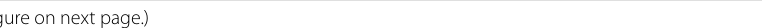
figure on next Fig. 5 Effects of miR‑29b gene transfer on renal injury in vivo. A Assessment of apoptosis. Representative epifluorescence images of TUNEL labeling of kidney histological sections at 5 weeks post gene transfer. Scale bar: 50 μm B , Quantification of TUNEL‑positive nuclei. Values are mean measured from 10 000 nuclei (n 3). C , D , Renal function was assessed by the level of serum creatinine and urea nitrogen in each group. n = tubular injury score in each group. F , G Kidney injury molecule‑1 (KIM‑1, E ) and neutrophil gelatinase‑associated lipocalin (NGAL, F ) in renal cortex determined by real‑time RT‑PCR. mRNA values were normalized by the levels of GAPDH mRNA and then expressed relative to the mean value for the control group (n 6). Values are mean SEM. * P < 0.05 vs. Control; # P < 0.05 vs. AngII rAAV9‑Negative control = ± +